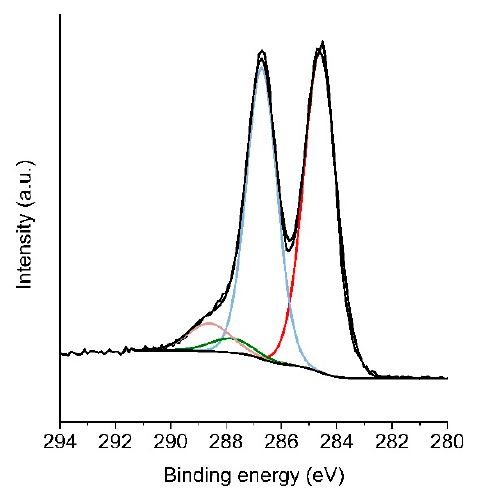
Figure A1. C1s spectra (XPS) of graphite oxide GO1.